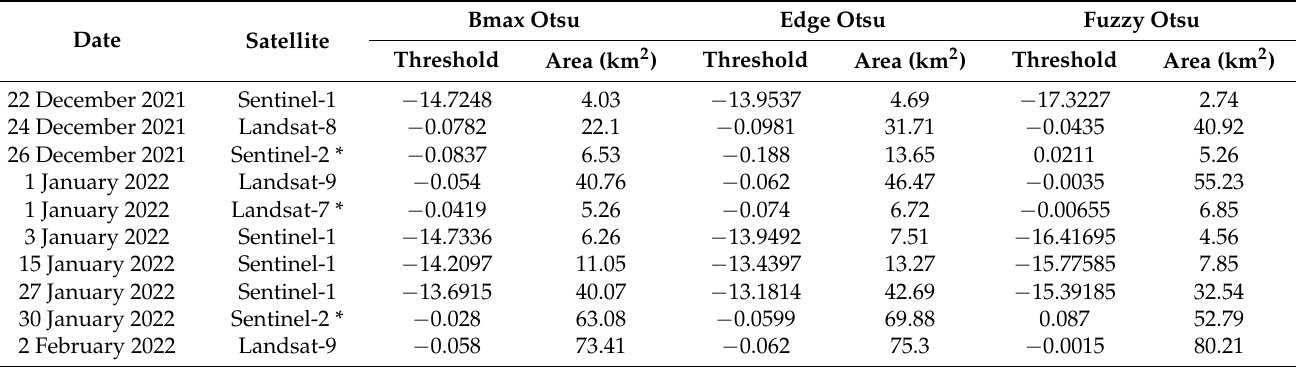
Table 3. The values of threshold values and areas (km 2 ) of each algorithm from the satellite